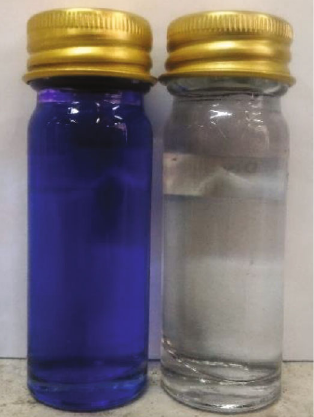
Figure 5: Comparison of colour between MB dye feed and fi ltrate water after adsorption process in batch column